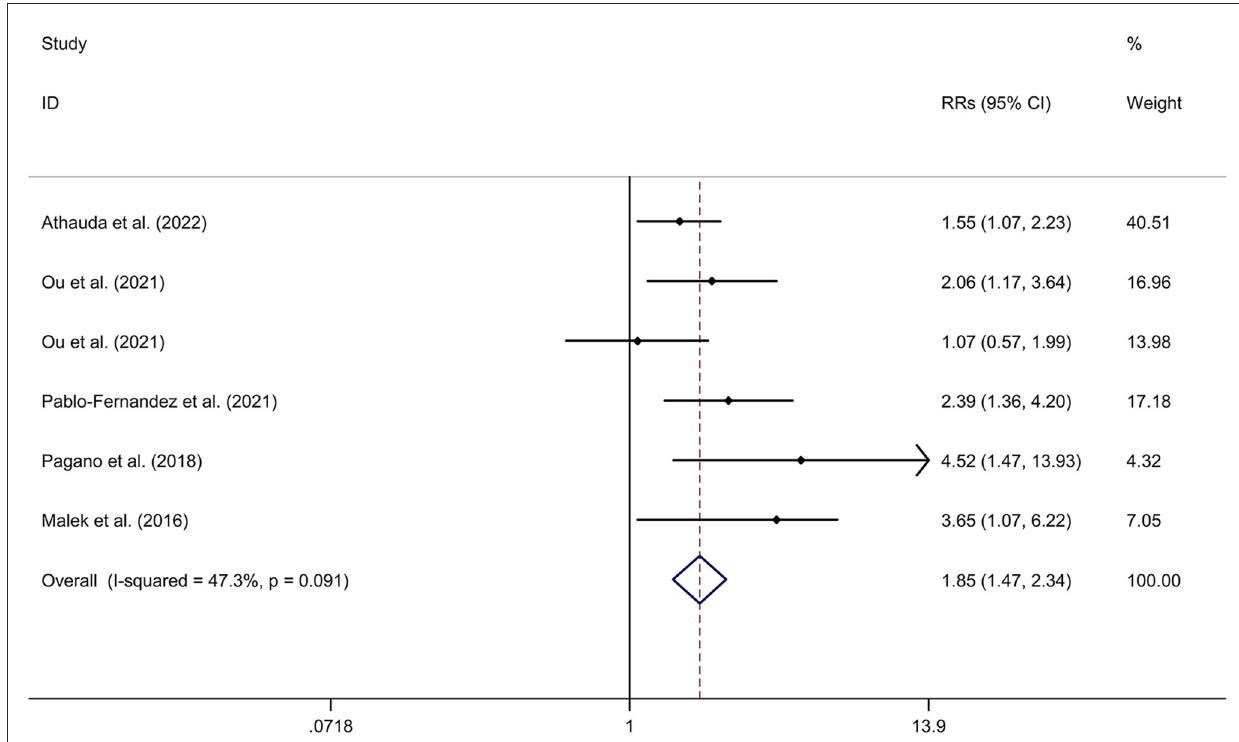
FIGURE3 Forest plot for association between DM and motor progression of PD. CI, confidence interval; DM, diabetes mellitus; PD, Parkinson’s disease; RR, relative risk.